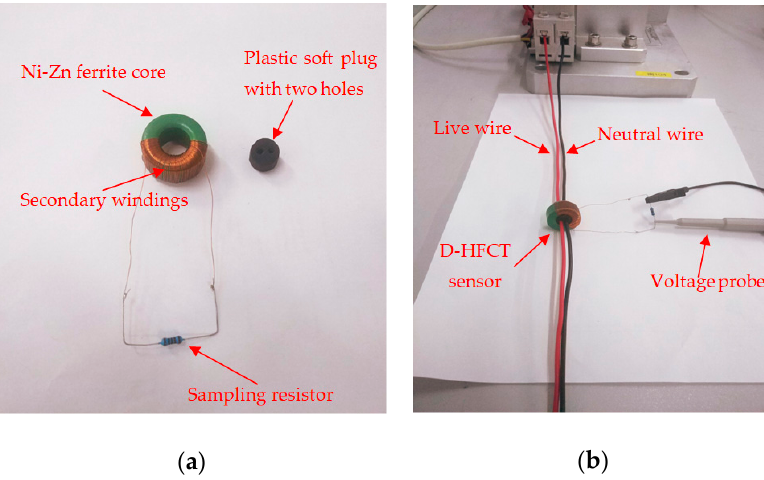
Figure 14. Composition and installation diagrams of the D-HFCT sensor. ( a ) Components of the D-HFCT sensor; ( b ) installation of the D-HFCT sensor. Table 4. Parameters of the Ni–Zn ferrite core.